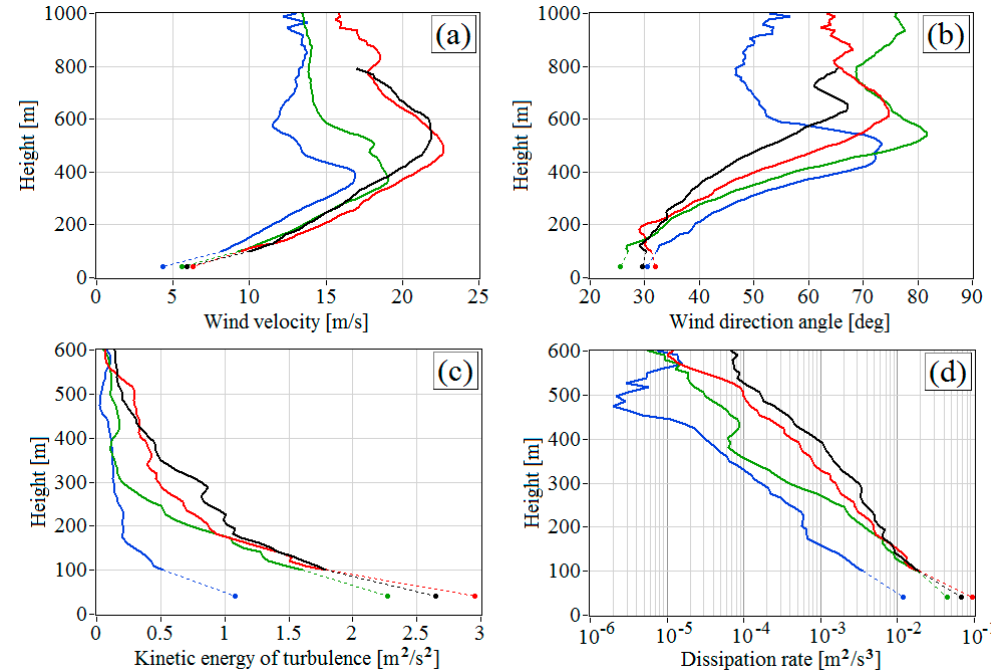
Figure 4. Vertical profiles of ( a ) wind velocity, ( b ) wind direction angle, ( c ) kinetic energy of turbulence, and ( d ) turbulent energy dissipation rate retrieved from measurements by the lidar employing conical scanning at the elevation angle of 35.3° at 21:00 local time (LT) on 23 July (black curves) and 00:00 (red curves), 03:00 (green curves), and 06:00 LT (blue curves) on 24 July 2018. The profiles of wind velocity and wind direction angle were retrieved from the data of one scan (measurement duration of 1 min), whereas the profiles of wind turbulence parameters were retrieved from the data of 20 scans. The circles indicate the results of measurements with a sonic anemometer at a height of 42 m. The dotted lines “stitch” the corresponding data, which is measured using a sonic anemometer and lidar.